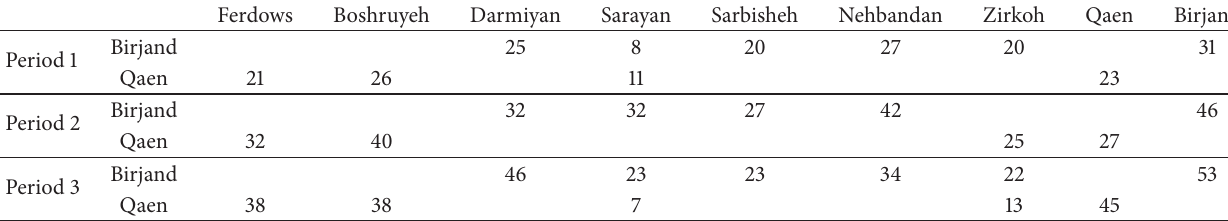
Table 12: Allocated commodity (type 1) ( ∗ 1000).